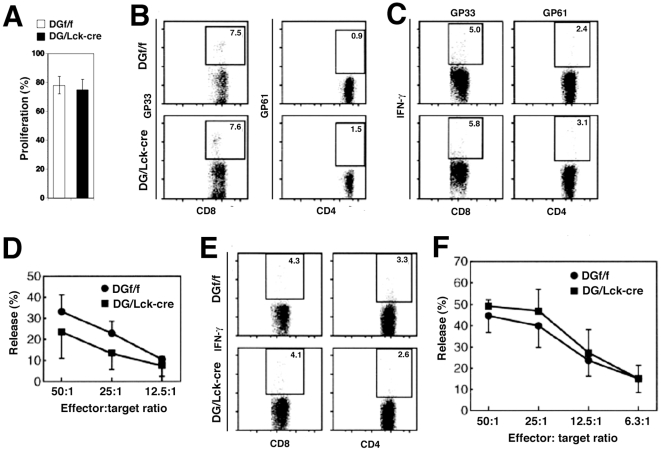
DG/Lck-cre Mice Show T Cell Responses Equivalent to Those of DGf/f Control Littermates During Allogeneic Stimulation or Acute LCMV Infection.(A) Splenic T cells were isolated from C57BL/6 (H-2b) DG/Lck-cre mice and littermate controls (DGf/f) and labeled with CFSE prior to co-culture with T cell-depleted splenocytes from Balb/c (H-2d) mice. Proliferating T cells (diluted CFSE) were assessed after staining with surface marker by flow cytometry analysis. The frequencies of proliferating T cells were quantified. (B–D) In Panels B, C and D, DG/Lck-cre mice and littermate controls (DGf/f) were inoculated intraperitoneally with LCMV ARM 1×105 pfu. Eight days later, splenocytes were harvested and analyzed. (B) Panel B shows numbers of LCMV-specific T cells as determined by MHC tetramer staining. Representative data of Db/GP33 (immunodominant virus-specific CD8+ T cell epitope) and IAb/GP61 (immunodominant virus-specific CD4+ T cell epitope) are shown. (C) Panel C displays intracellular expression of IFN-γ after stimulation of splenocytes for 5 h with peptides GP33 and GP61 specific for CD8+ and CD4+ T cells respectively. Representative data from one of at least five independent experiments all with similar results. (D) Cytotoxic activity of virus-specific T cells assessed by 51Cr release assay. Specific lysis at varying effector to target cell ratios is shown. Values indicate the percentage of specific 51Cr releasing from target cells. The data represent the average and standard deviation for four mice per group. (E–F) DG/Lck-cre mice form virus specific CD8+ and CD4+ memory T cells after LCMV infection. DG/Lck-cre and DGf/f C57BL/6 mice were initially infected intraperitoneally with 1×105 pfu of LCMV ARM. All mice cleared infectious virus by 15 days and at 45 days post-virus inoculation were challenged intravenously with 2×106 pfu of LCMV Cl 13 to induce memory T cells [23], [30]. Spleen cells were isolated two days after Cl 13 infection. (E) In Panel E LCMV-specific T cells were determined by intracellular staining of IFN-γ producing T cells after stimulating with peptides GP33 and GP61 for 5 h, (F) while in Panel F T cell effector function was detected by 51Cr release assay.